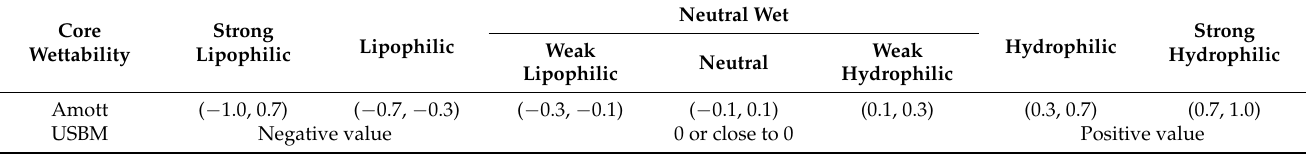
Table 1. Wettability criteria of the combined Amott/USBM method [3,5].